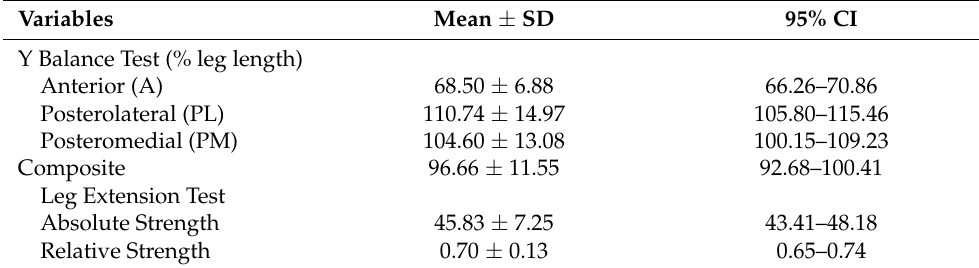
Table 2. Results of the unilateral leg extension test and the Y Balance Test ( n = 33).